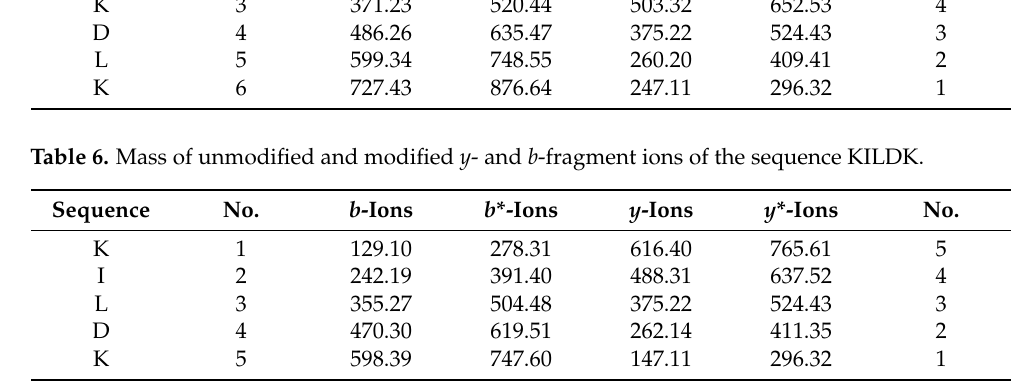
Table 5. Mass of unmodified and modified y - and b -fragment ions of the sequence ELKDLK. Sequence